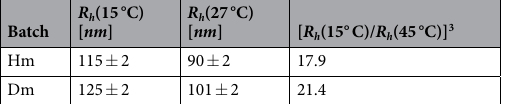
Table 1. Summary of the properties of the microgels used for the SANS and SAXS experiments: Dm and Hm refer to the deuterated and hydrogenated particles, respectively. R h [15 °C] and R h [27 °C] are the hydrodynamic radii measured with DLS at a temperature of 15 °C and 27 °C. Also shown is the swelling ratio defined as ( R h [15 °C]/ R h [45 °C]) 3